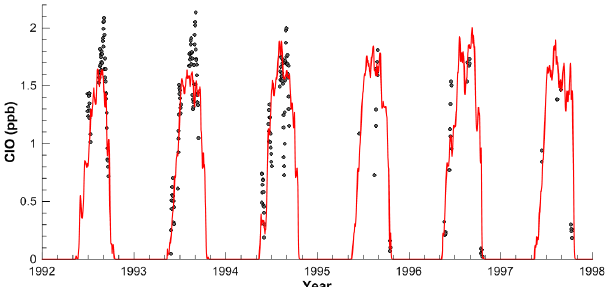
Fig. 2. UARS MLS daytime ClO measurements 20 May to 20 Oc- tober (black dots) and semi-empirical model fit (red line) for 1992– 1997. MLS observations are on the 520K isentropic surface, and the model output is on the 50hPa pressure